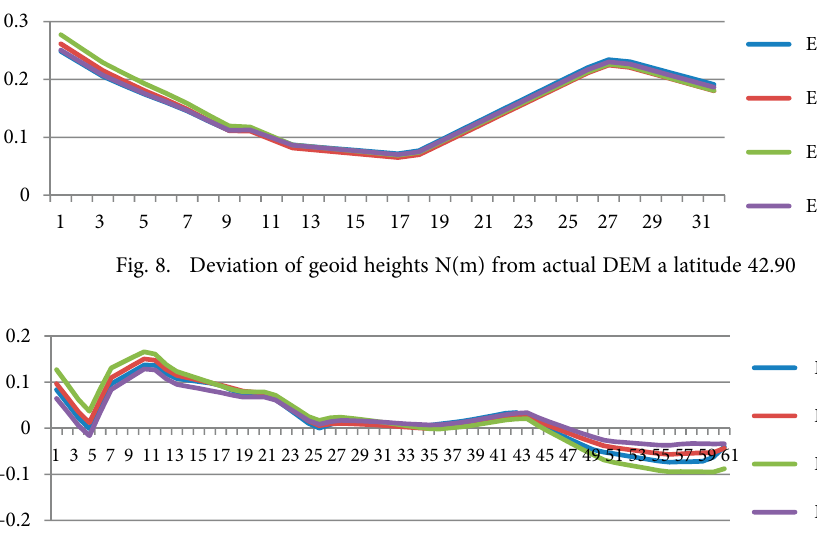
Fig. 9. Deviation of geoid heights N(m) from actual DEM a latitude 42.75